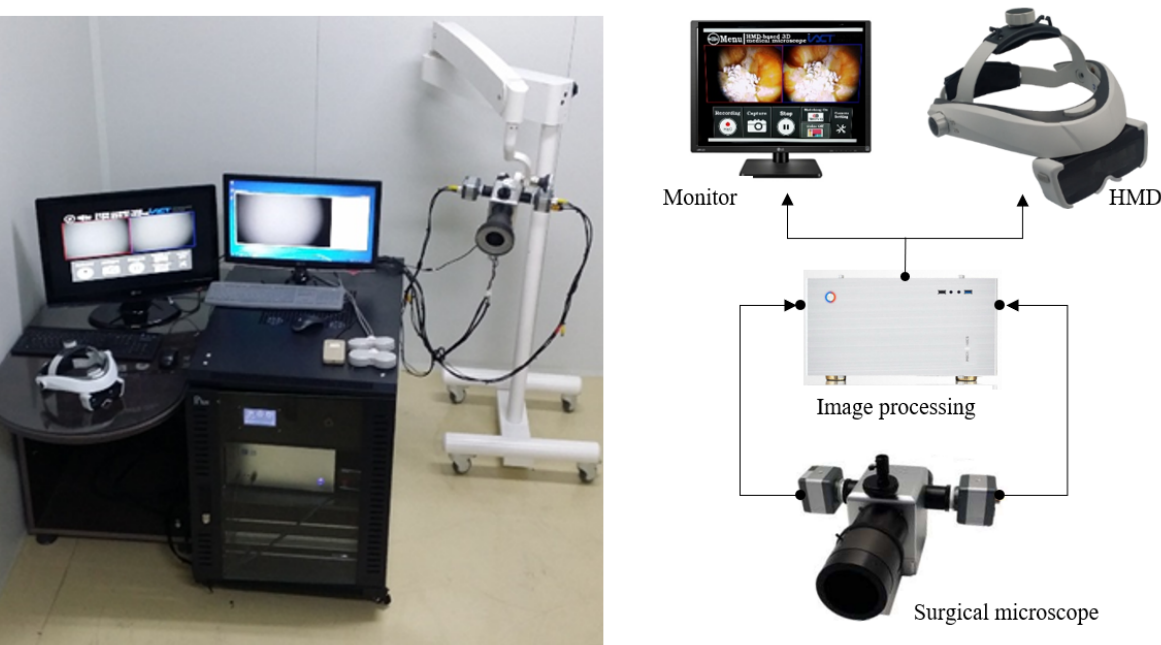
Figure 1. Left: surgical microscope system based on see-through type 3D head-mounted display (HMD); right: surgical images measured using 2